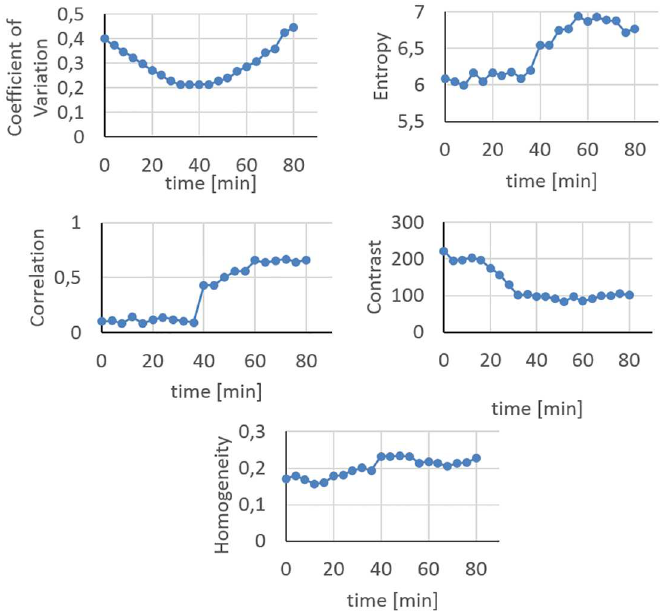
Fig 8. Time dependence of the heterogeneity parameters. Parameter values belongingto different time points are assignedto different textural patterns.